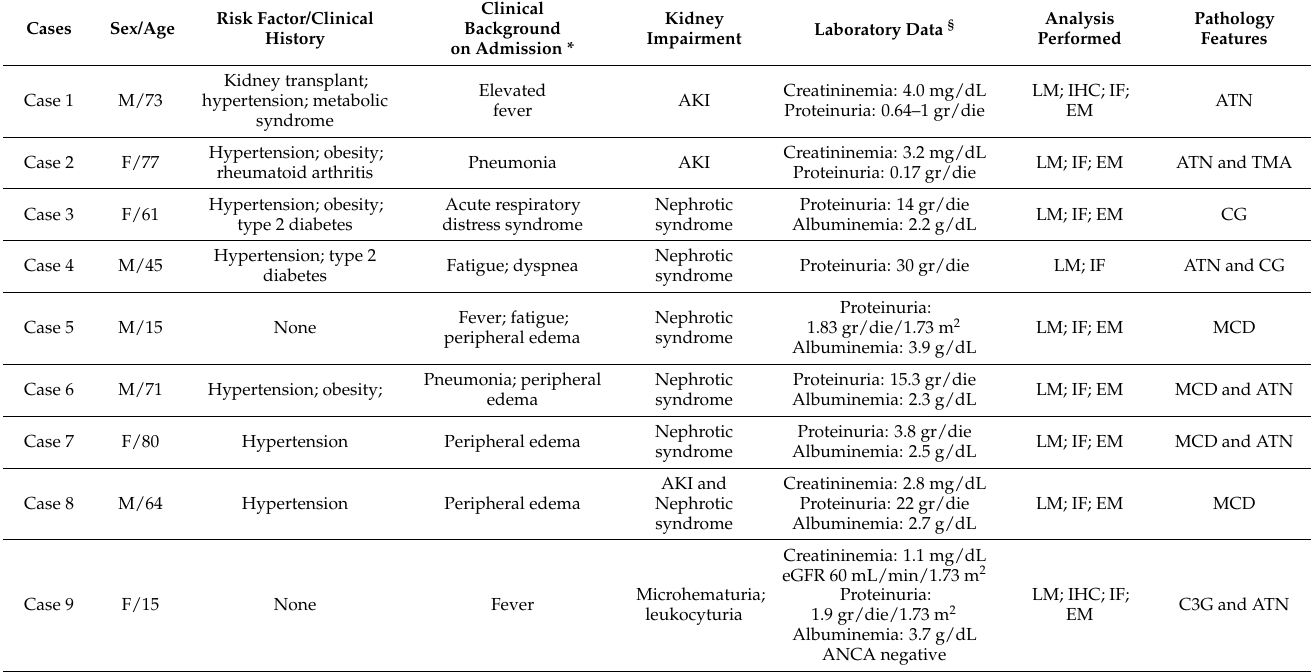
Table 2. Clinical and pathology data of our